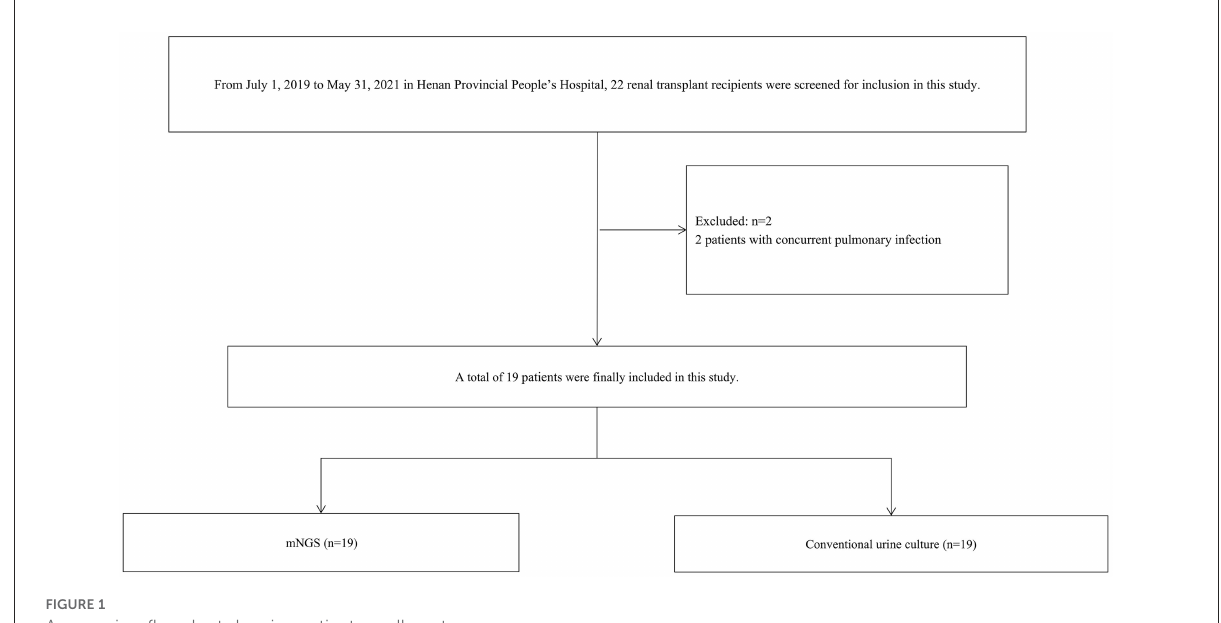
FIGURE1 An overview flowchart showing patient enrollment.